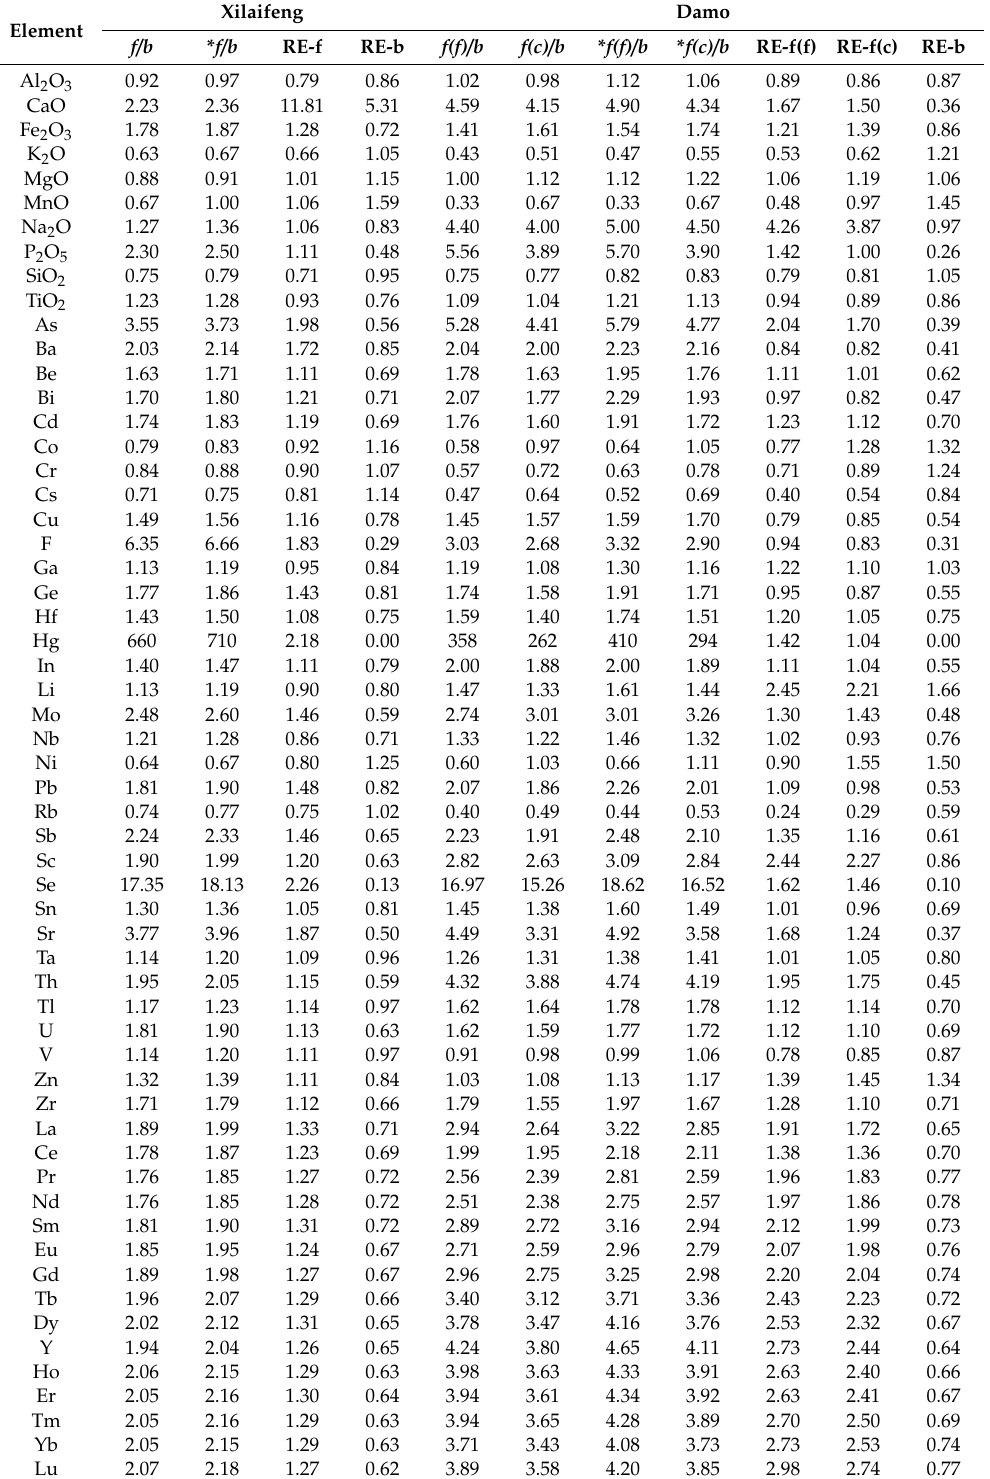
Table 6. Average ratios of element concentrations in the fly ash vs. bottom ash and relative enrichment (RE) coe ffi cient of elements for the Xilaifeng and Damo power plants.